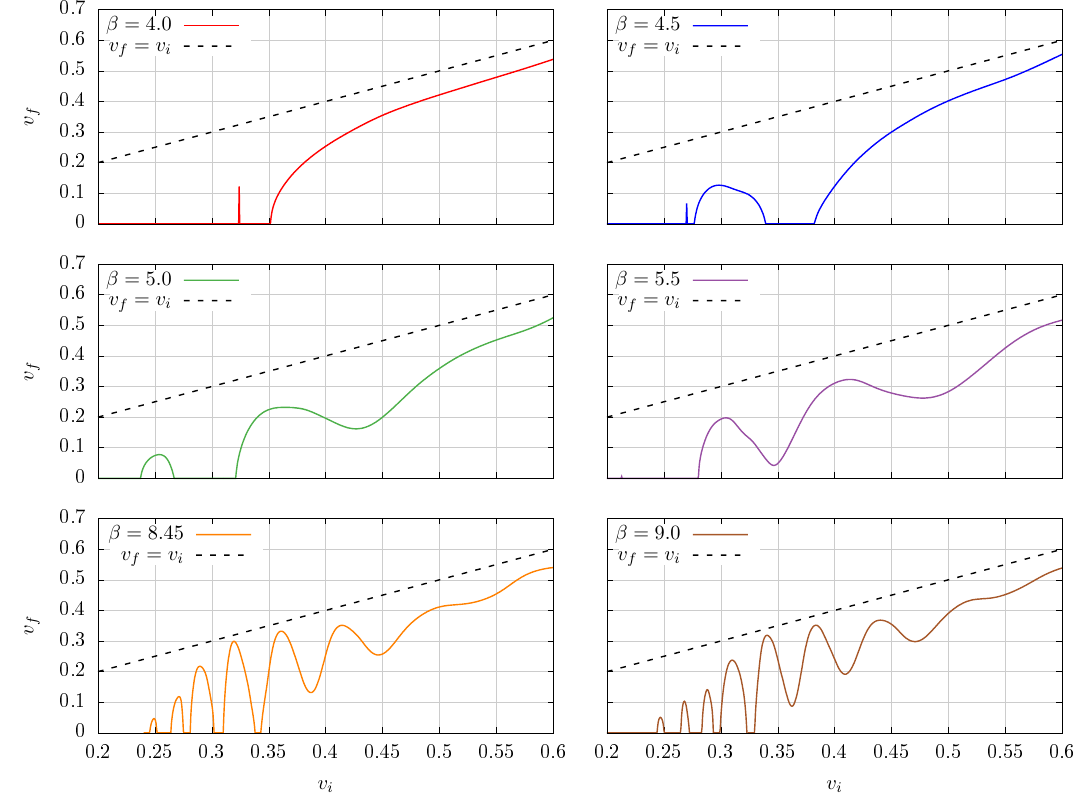
Figure 25 . Inner subkink velocity shortly after the second subkink-subkink collision at x = 0 as a function of initial velocity in the near-critical region, illustrating the mechanism for the formation of the overhanging